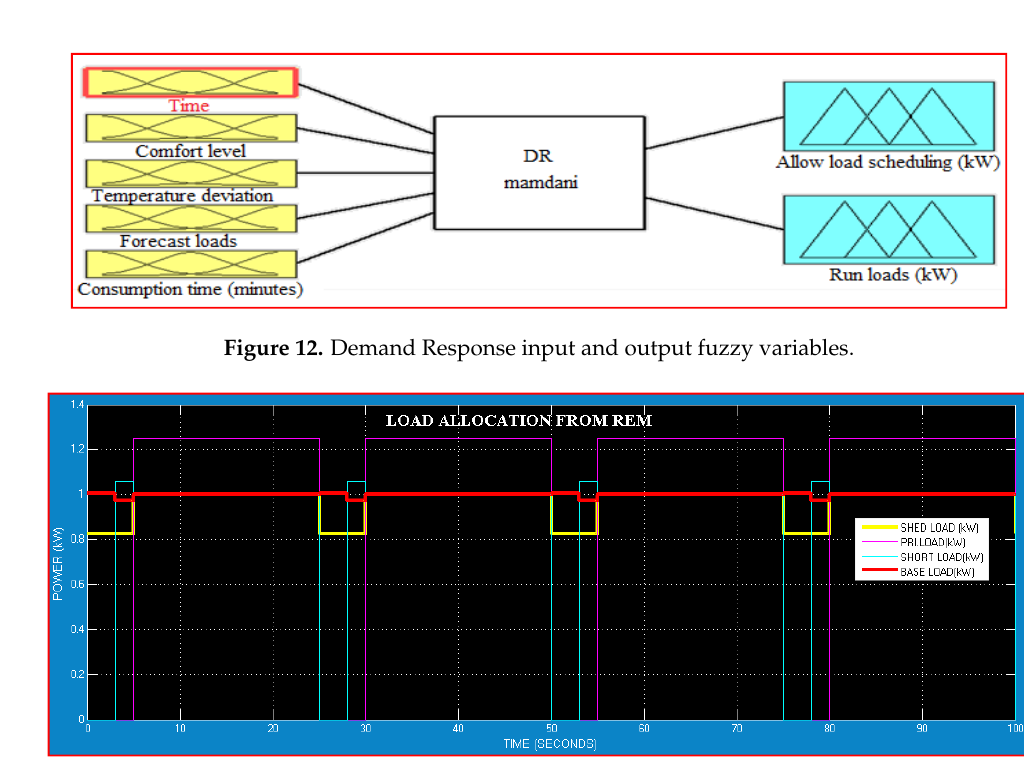
Figure 13. Fuzzy load allocation four types of loads in Simulink model.